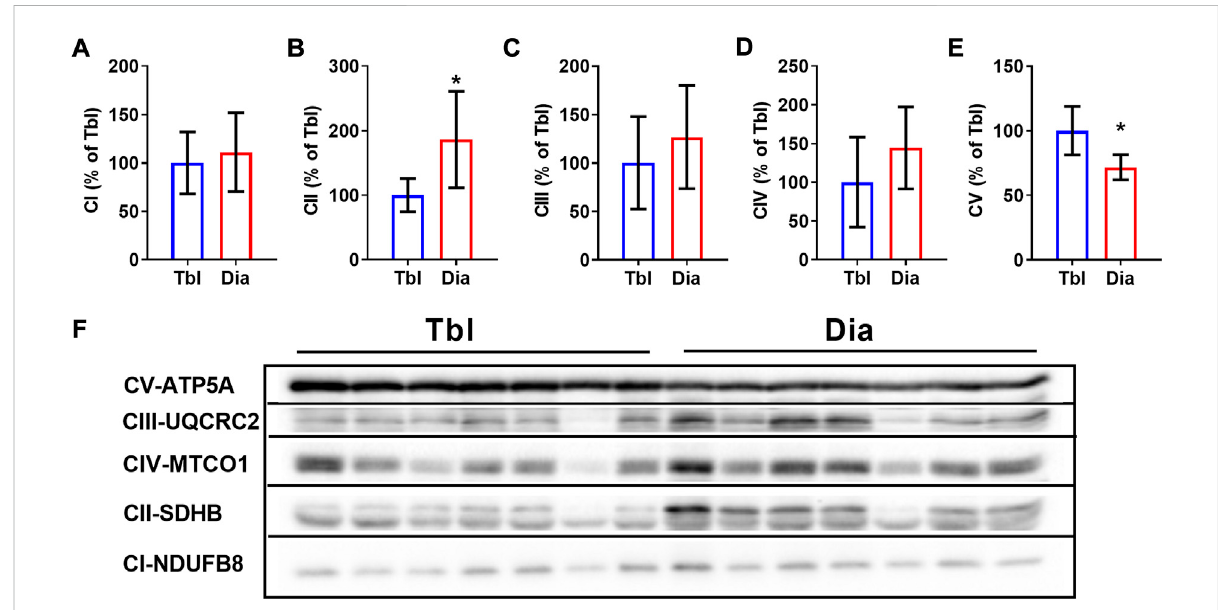
FIGURE 3 Rat triceps brachii muscle and diaphragm muscle differ in the contents of oxidative phosphorylation complexes. (A – E) The relative contents of CI(A),CII(B),CIII(C),CIV(D)andCV(E)oxidativephosphorylationcomplexesintricepsbrachiimusclelonghead(Tbl)anddiaphragmmuscle(Dia)of sedentary rats ( n = 7). (F) Representative Western Blot images of triceps brachii and diaphragm muscles oxidative phosphorylation complexes in sedentary rats. Images of CI-CV complexes were taken at different exposure times. * p < 0.05 compared to Tbl (unpaired Student ’ s